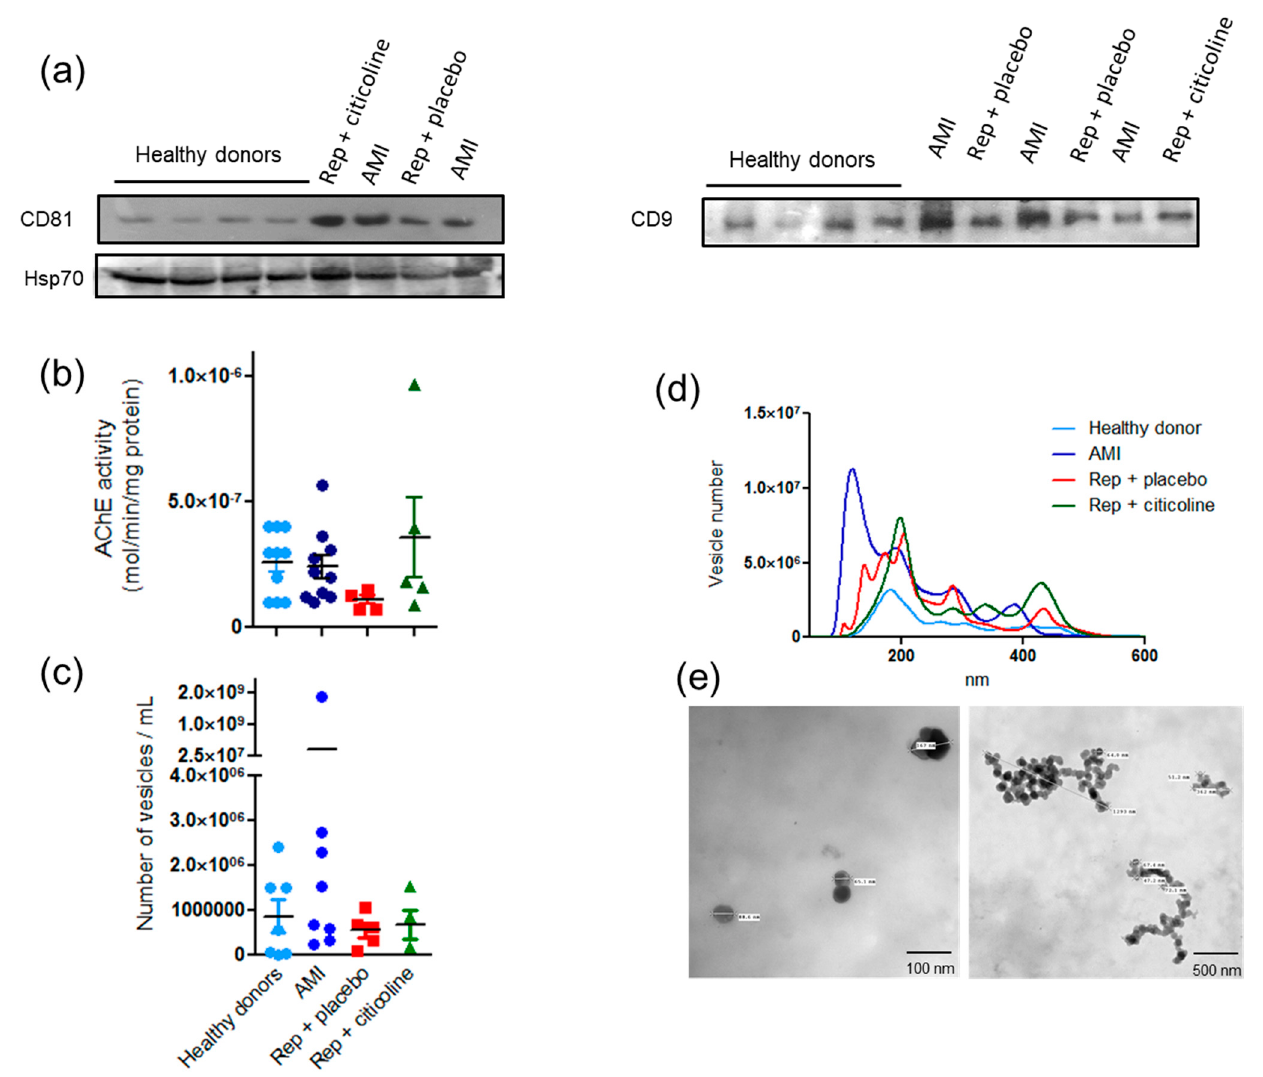
Figure 2. Characterization of exosomes from plasma of healthy donors and plasma of AMI patients be- fore and after coronary angioplasty in presence of citicoline: ( a ) Western-blot analysis of tetraspanins CD9, CD81, and Hsp70. ( b ) Acetylcholine esterase activity. Results shown are the mean ± SE of at least 8 independent exosome samples from each group. ( c ) Quantification of particles number with size between 50 and 100 nm by nanoparticle tracking analysis (NTA), results are the mean ± SE of at least 5 independent exosomes’ samples from each group). ( d ) Representative image of particles size distribution between 50 and 600 nm determined by NTA. ( e ) Representative transmission electron microscopy images of exosome samples of the different